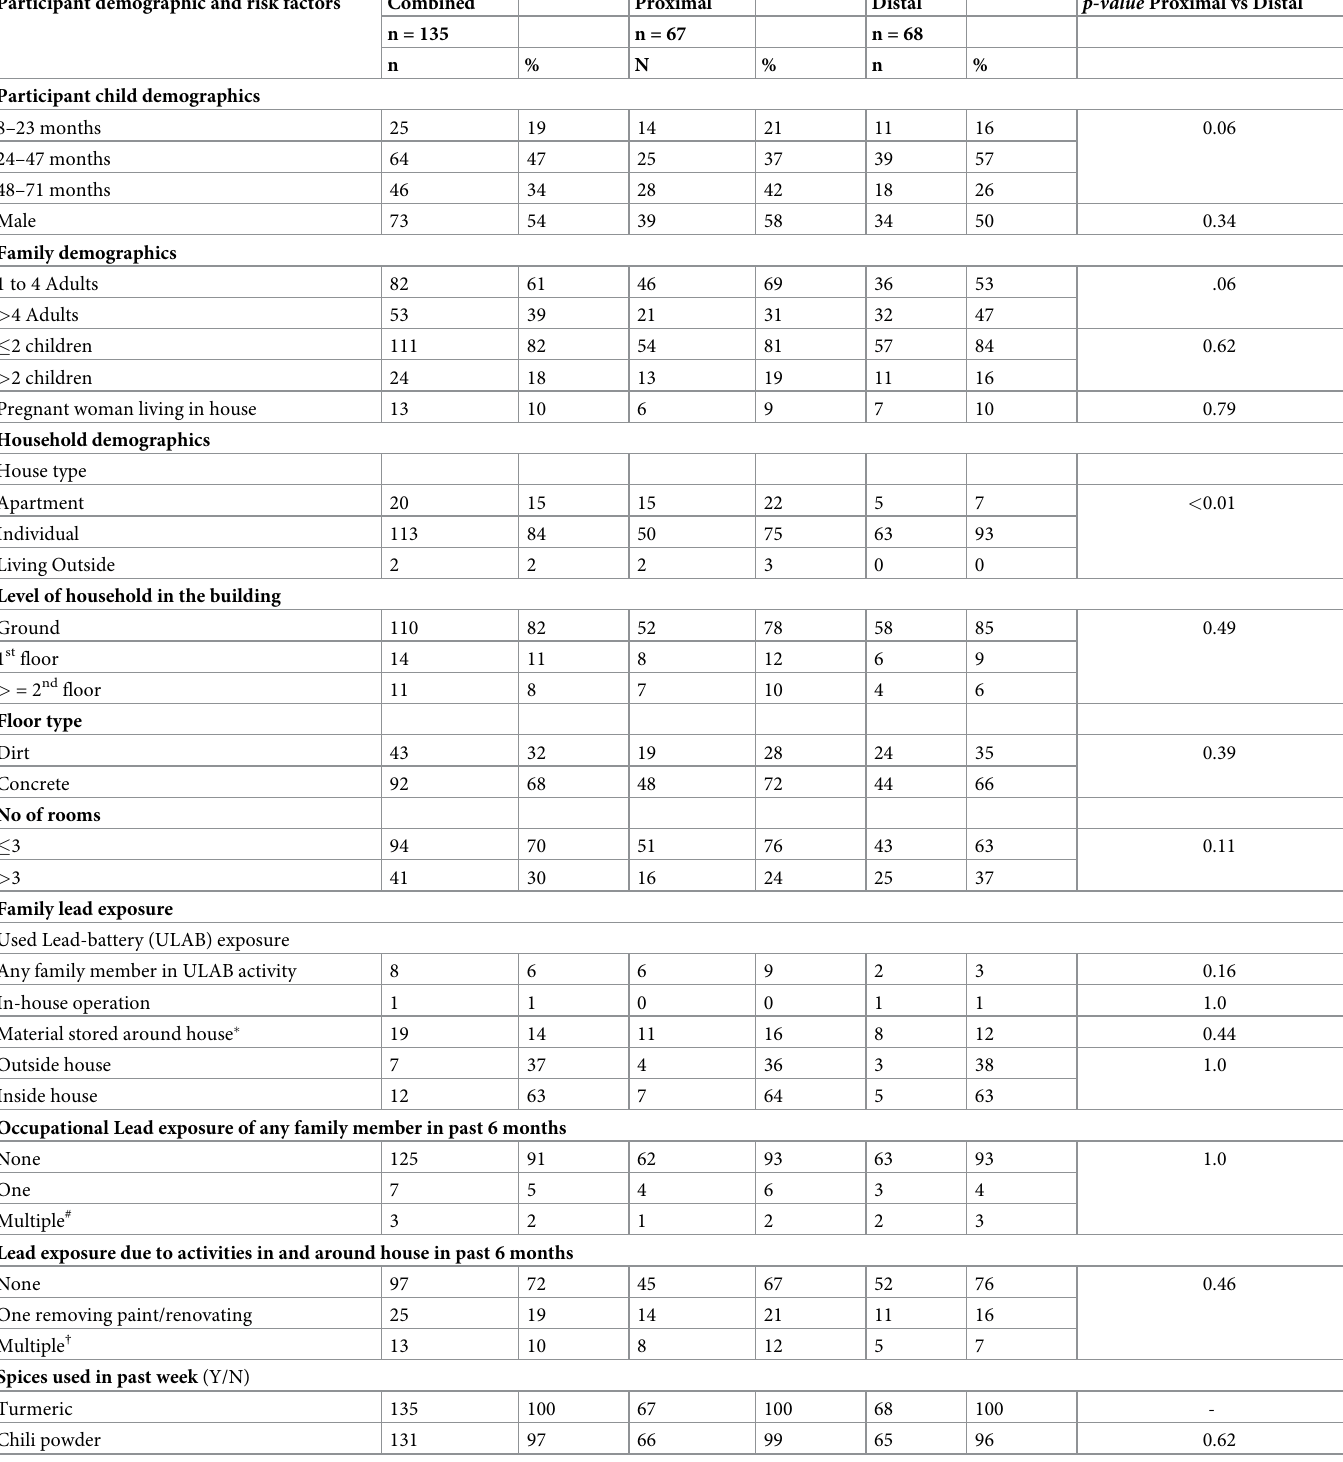
Table 1. Participant characteristics and risk factor distribution for all children and stratified by distance (Proximal vs. Distal) to ULAB activities. Patna, Bihar, Feb- ruary 2020. Participant demographic and risk